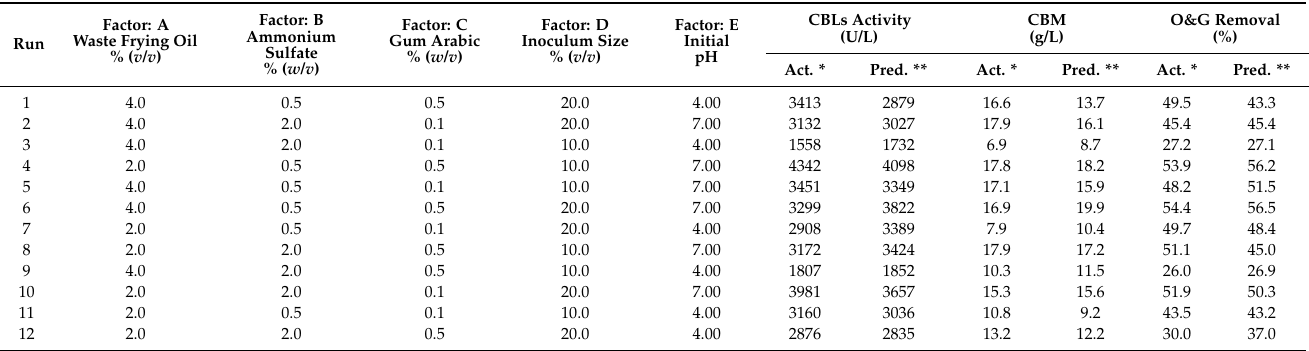
Table 2. The design matrix of Plackett-Burman design (PBD) for evaluating significant factors influencing CBLs, CBM, and O&G removal.